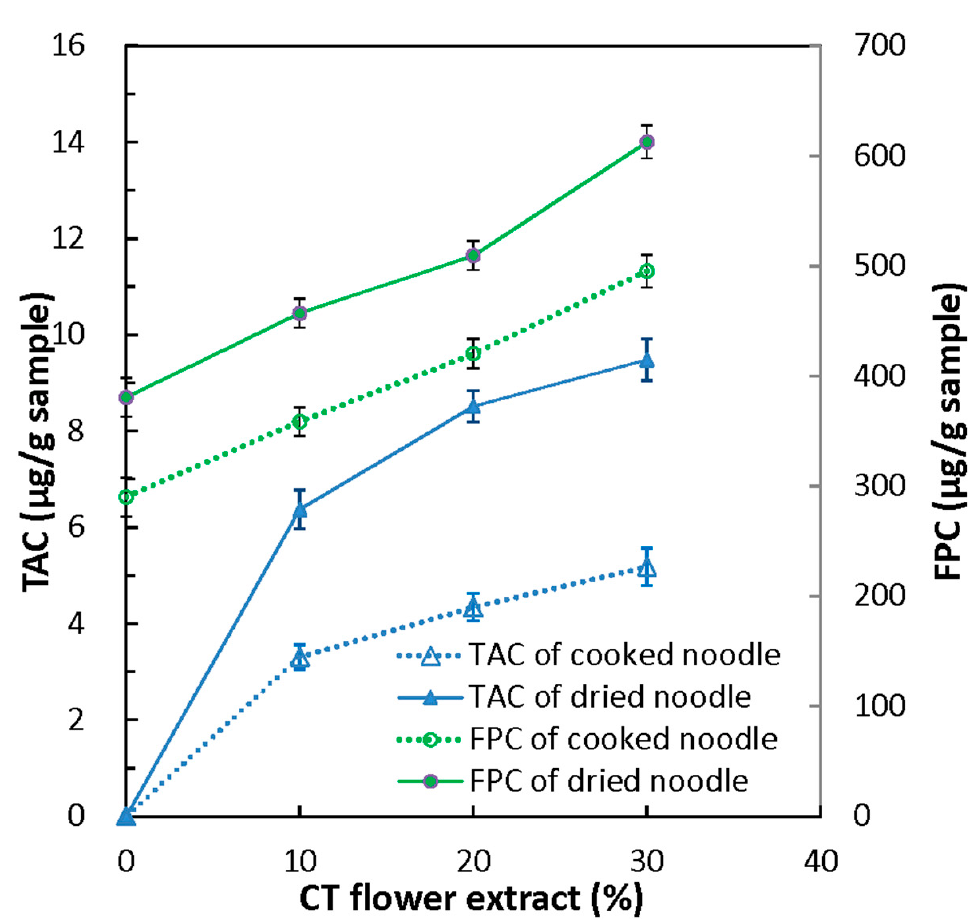
Figure 1. Total anthocyanin content (TAC) and free phenolic content (FPC) of dried and cooked noodles with various CTFE levels.